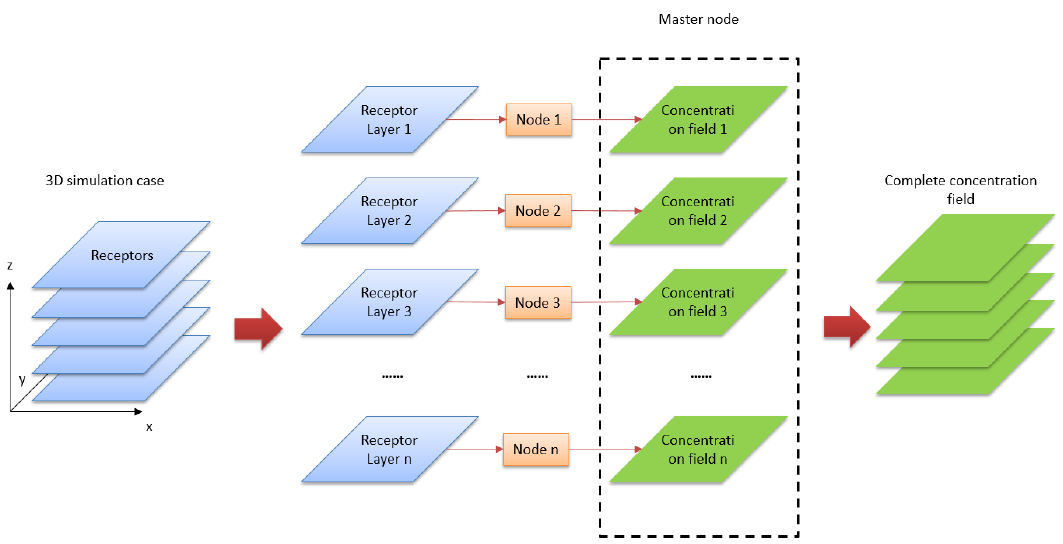
Figure 4. Parallelization method for the CALPUFF module.